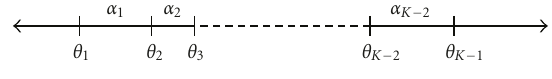
Figure 1: Ranking projection on the real